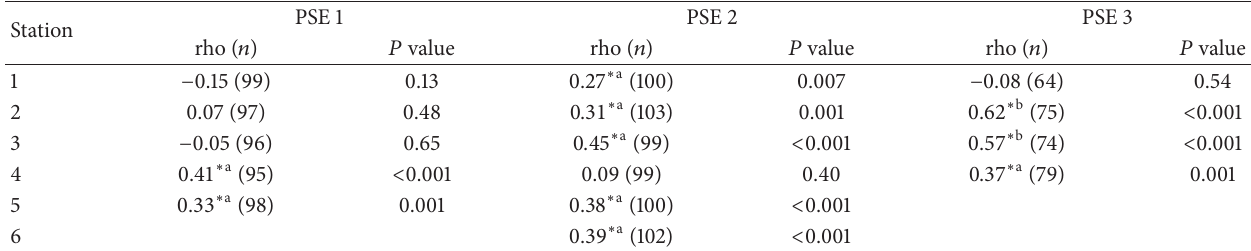
Table 4: Correlation between checklist and GRS scores within each station for each